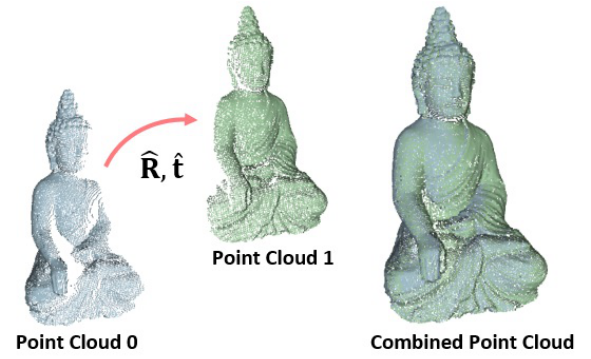
Figure 8. Point clouds of the two exemplary views. The resulting transformation P = ( ˆ R ,ˆ t ) aligns the point cloud of the first view to the one of the second view. The registered combined point cloud is shown besides.